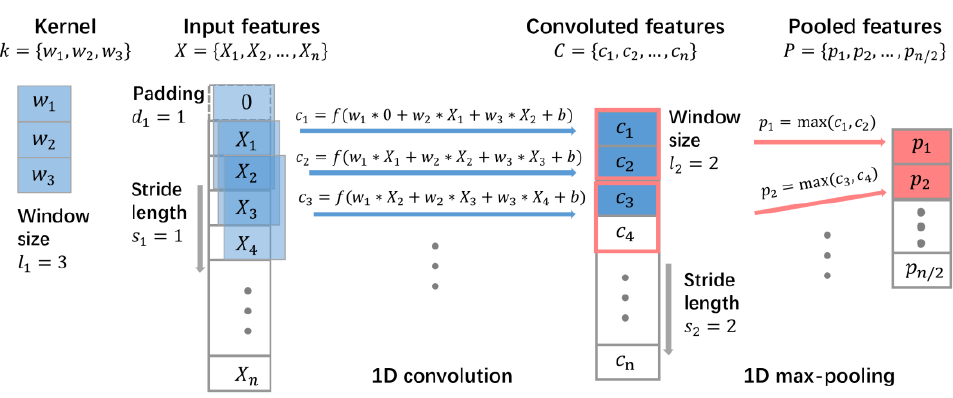
Figure 7. Illustration of the one-dimensional convolution and pooling operations.